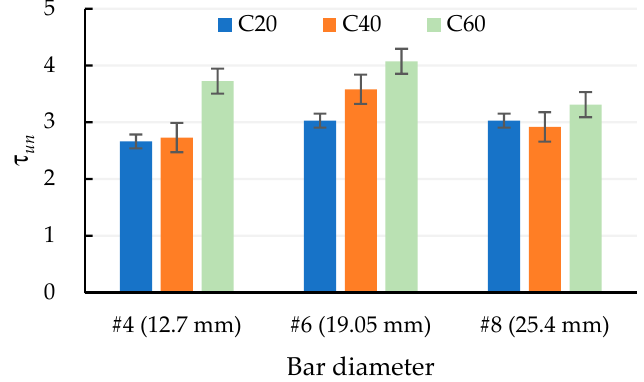
Figure 13. Normalized ultimate bond strength of different rebar diameters and concrete strength grades.